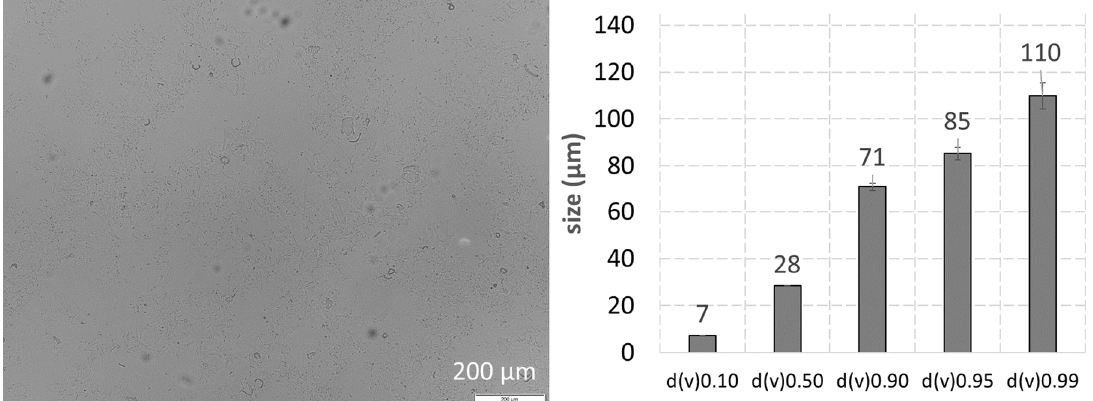
Figure 5. Physico-chemical characterization of crude PlantCrystal-PEVs—( left ): light microscopy, ( right ): LD analysis.